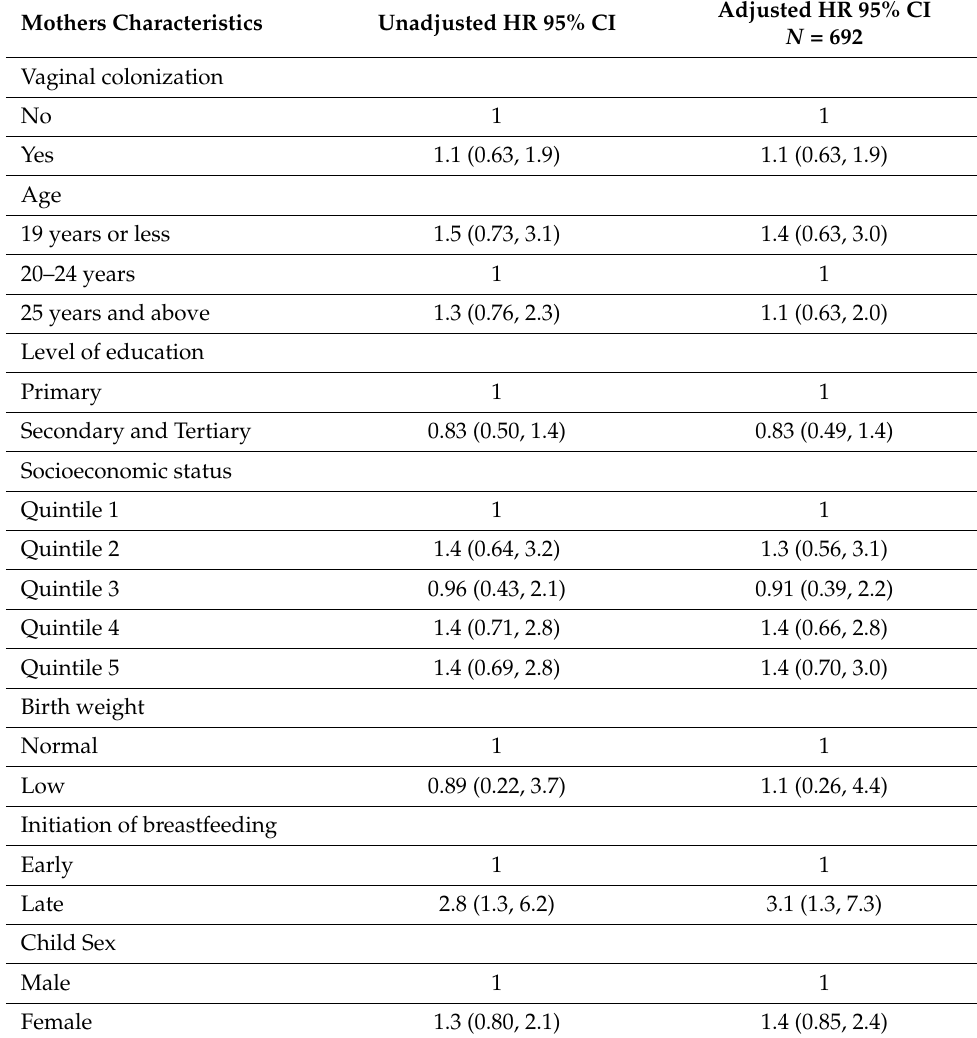
Table 3. Factors associated with omphalitis among neonates at the three study sites in central Uganda. Mothers